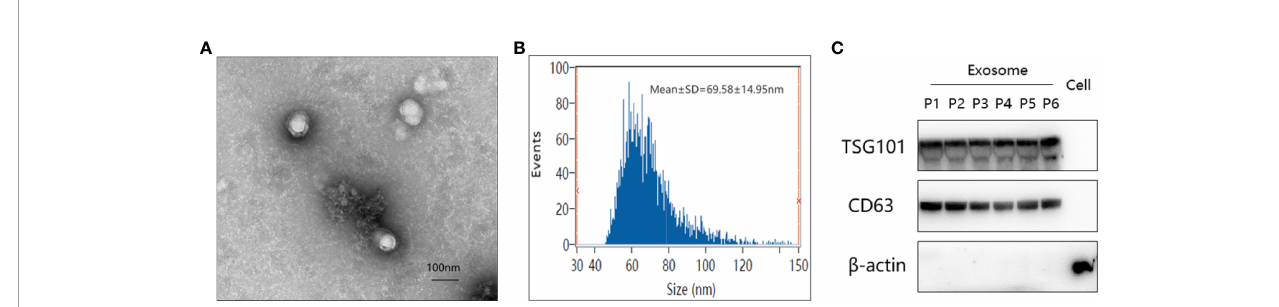
FIGURE 2 | Veri fi cation of plasma-derived exosomes from pancreatic cancer patients. (A) Transmission electron micrograph of isolated exosomes. Scale bar = 100 nm. (B) Size distribution measurements of isolated exosomes by fl ow cytometry. (C) Western blot analysis of exosome-enriched proteins (Tsg101 and CD63) and a control marker ( b -actin) in isolated exosomal proteins from six different groups of patients and the total protein from PANC-1 cells. (P1 – 6 represented patients from PC at stage I/II, PC at stage III/IV, well-differentiated P-NET, PCLs, CP, and HC, respectively).